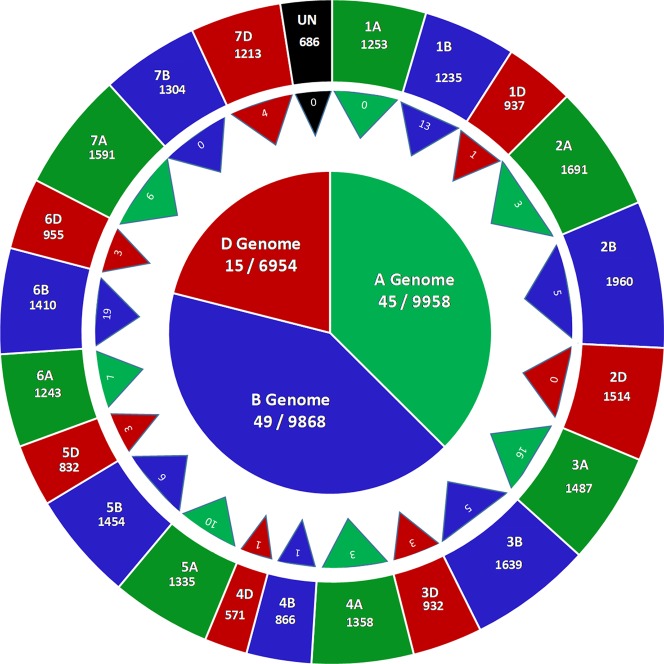
Genome wide distribution of 27,466 single nucleotide polymorphisms (SNPs) markers (outer circle), number of marker trait associations across 21 chromosomes (triangles) and number of marker trait associations across three genomes (inner circle) in a soft wheat association mapping panel (SWAMP).